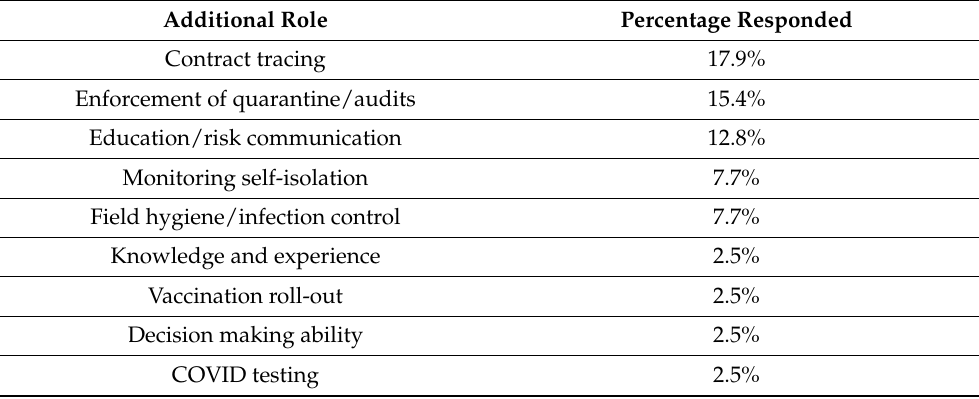
Table 2. Additional roles during COVID-19 as nominated by